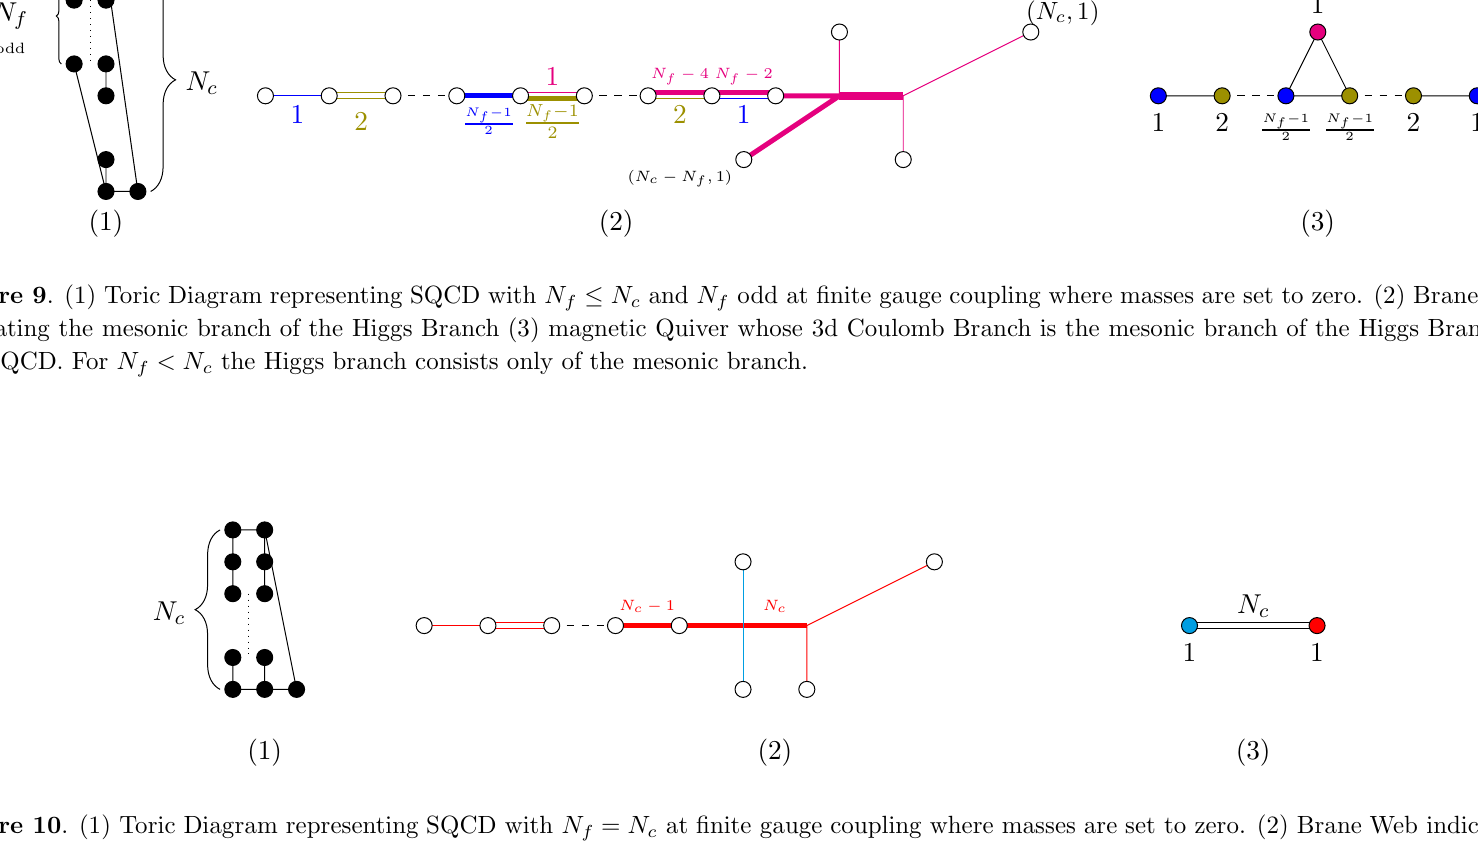
Figure 10 . (1) Toric Diagram representing SQCD with N f = N c at finite gauge coupling where masses are set to zero. (2) Brane Web indicating the baryonic branch of the Higgs Branch (3) magnetic Quiver whose 3d Coulomb Branch is the baryonic branch of the Higgs Branch of our SQCD. For N f < N c there is no baryonic